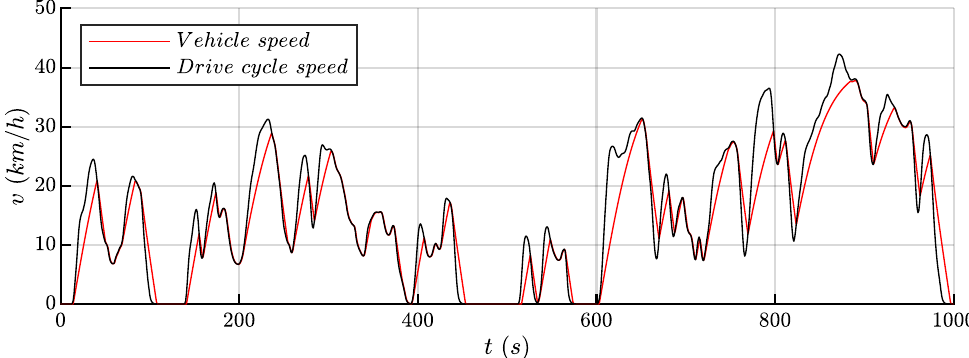
Figure 2. Vehicle speed profile vs. drive cycle speed. Pilot block